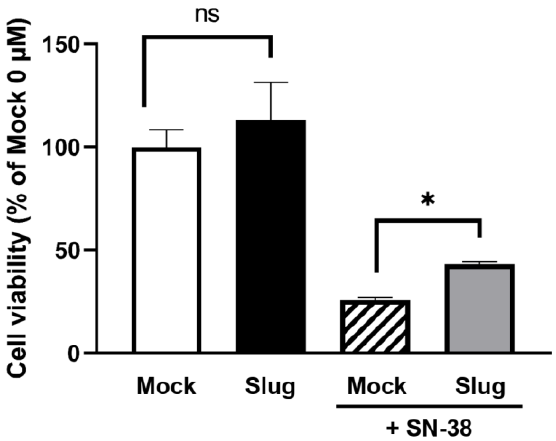
Figure 6. Cell viability assay using 50 µ M SN-38. The cell viability of Slug-transfected cells increased